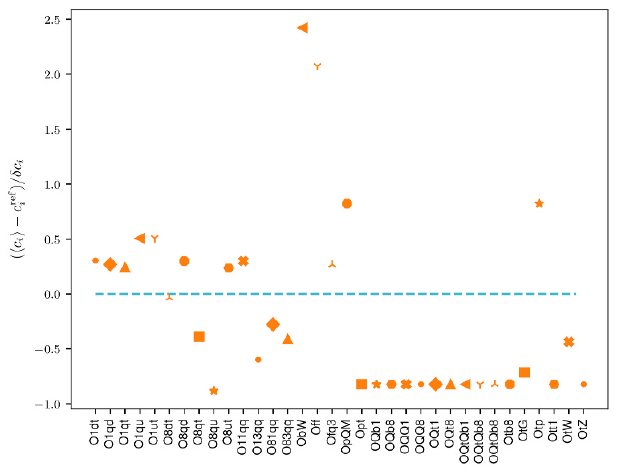
Figure 9 . Same as (cid:12)gure 6 (left) for the closure tests in which each of the N has been constrained separately from all the others. The dashed blue line indicates the Standard Model value c ref = 0, which is the true underlying law in these closure i g f